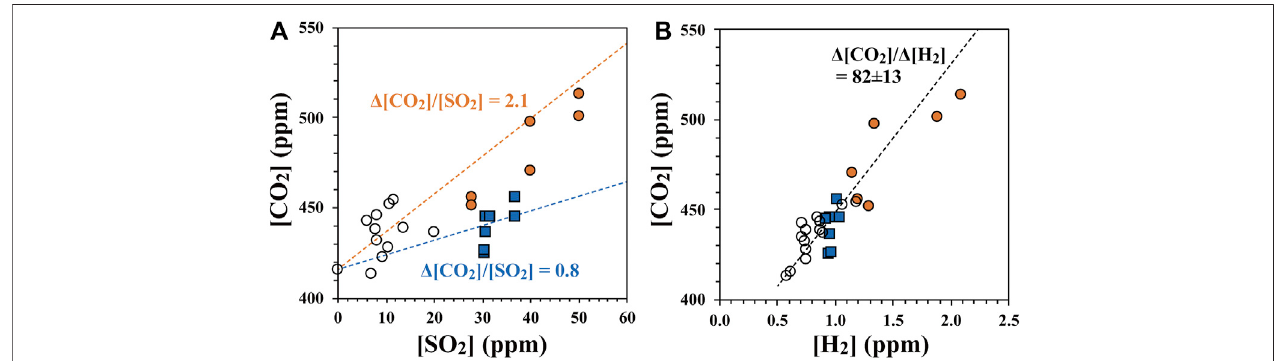
FIGURE 5 | (A) Relationship between the concentrations of SO 2 and CO 2 and (B) that between the concentrations of H 2 and CO 2 in the plume/air samples collected automatically by SelPS (orange circles: plume samples derived from the main vent; blue squares: those derived from the southern fumaroles), as well as those derivedfromthemainvent andcollectedmanually intopre-evacuated fl asks(whitecircles)at theNakadakecrater,Asovolcano.Theorangedottedlinein (A) represents the regression line calculated for those derived from the main vent and the background air sample. The blue dotted line in (A) represents the regression line calculated for those derived from the southern fumaroles and the background air sample. The black dotted line in (B) represents the regression line calculated for all the plume/air samples. All the regression lines were calculated according to Cantrell, (2008). The Δ [CO 2 ] (or Δ [H 2 ]) values in the fi gures denote excess CO 2 (or H 2 ) from CO 2 (or H 2 ) in the background